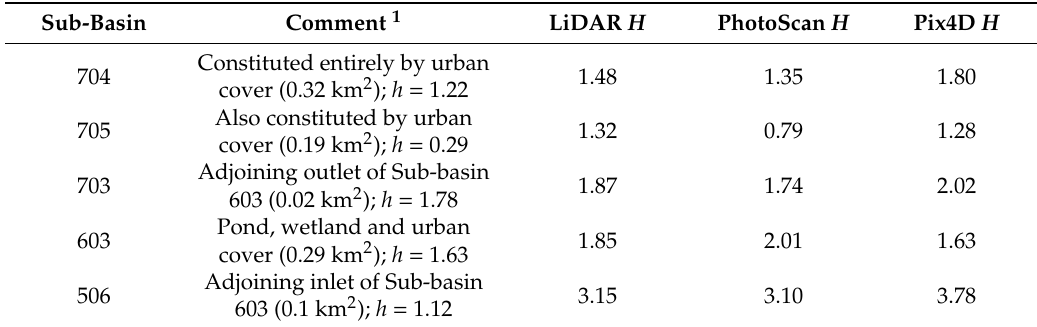
Table 3. H (m) input used for a flood event estimation for each DEM sub-basin.